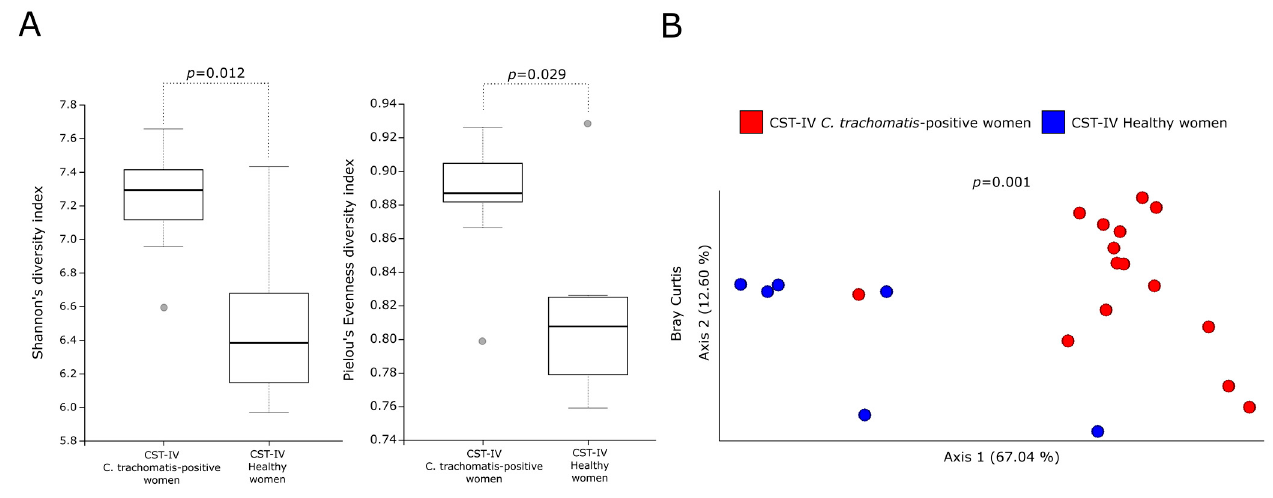
Figure 3. Alpha- and beta-diversity indexes of the predicted metabolic pathways in the CST-IV microbiota between C. trachomatis -positive women and healthy controls. ( A ) Shannon’s and Pielou’s evenness indexes; ( B ) Principal coordinate analysis of Bray-Curtis index. The gray circles in the boxplots represent the outliers; each colored circle represents the predicted metabolic pathways from each CST-IV